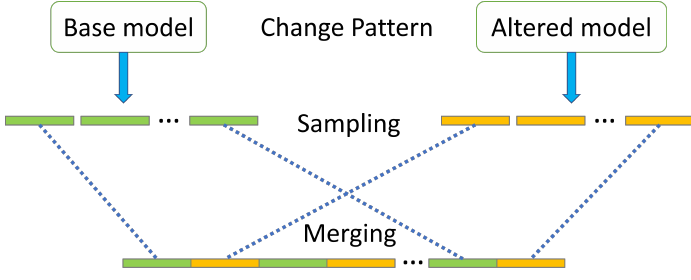
Figure 4. Log generation for sudden